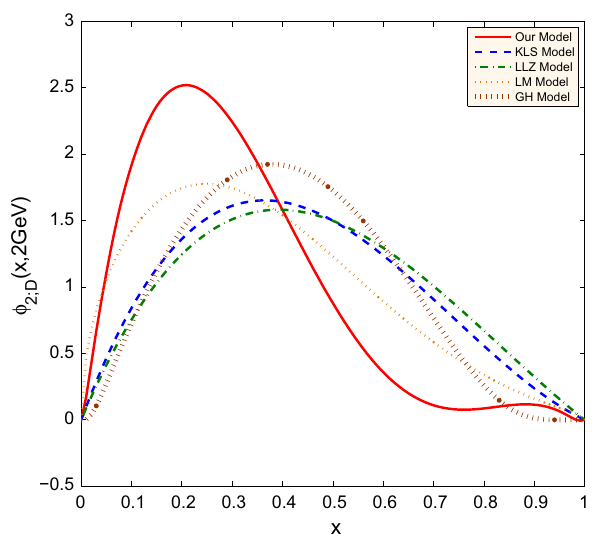
Fig. 5 A comparison of the D -meson leading-twist DA φ 2 ; D . The solid, dashed, dash-dotted, dotted and the thick dotted line are for our present model (11), the KLS model [23,24], the LLZ model [25], the LM model [30], and the GH model [34], respectively respectively. Our model of φ 2 ; D prefers a narrower behav- ior in low x -region than other models. It has a peak around